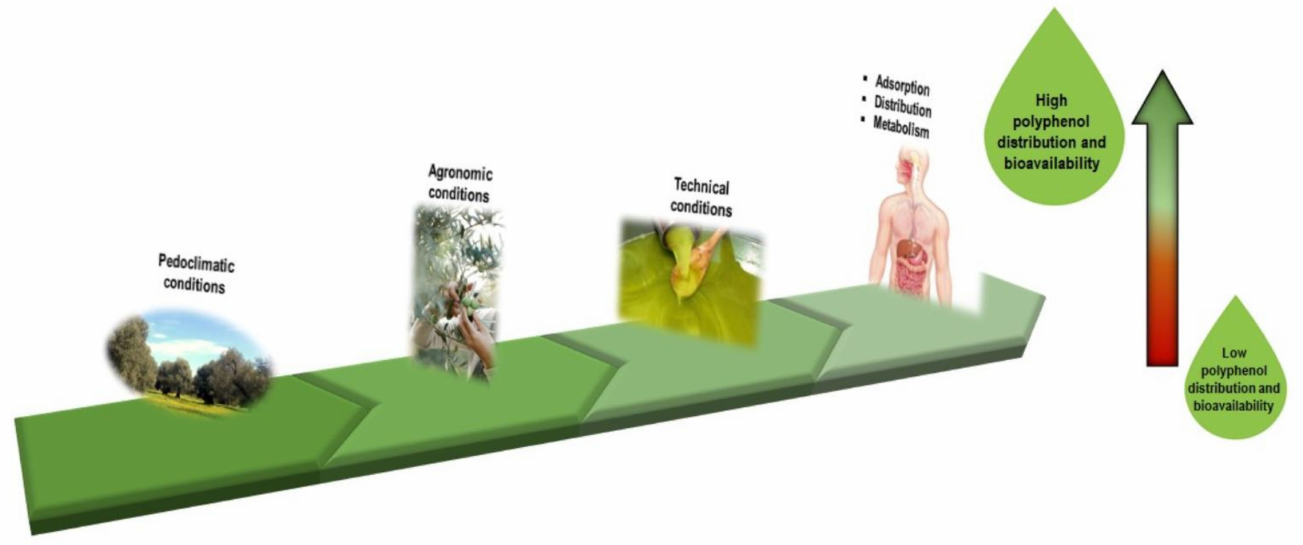
Figure 1. A representative illustration of the variations influencing polyphenol distribution and